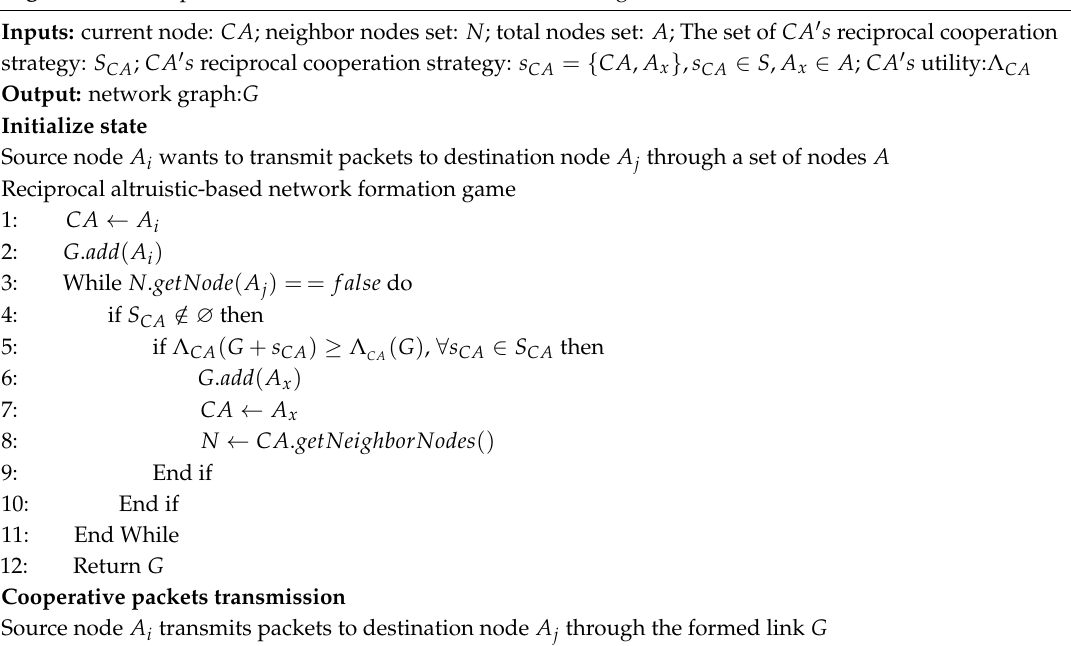
Algorithm 2: Reciprocal altruistic-based network formation algorithm